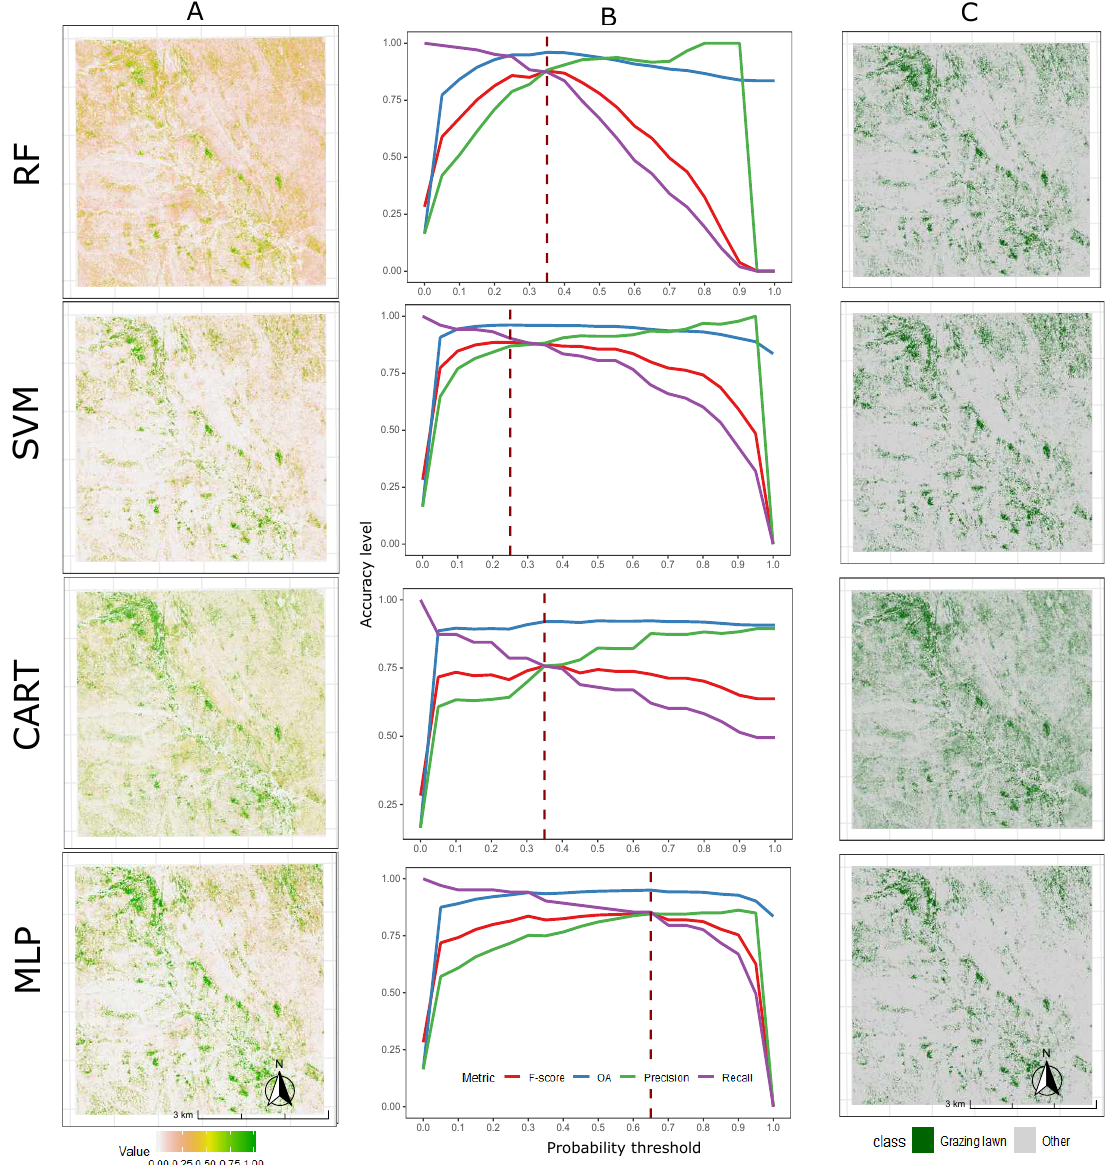
Figure 8. Grazing lawn occurrence probability surfaces ( A ); optimal probability threshold plot ( B ); and binary map of grazing lawn and other cover ( C ) derived from RF, SVM, CART and MLP models for the Satara